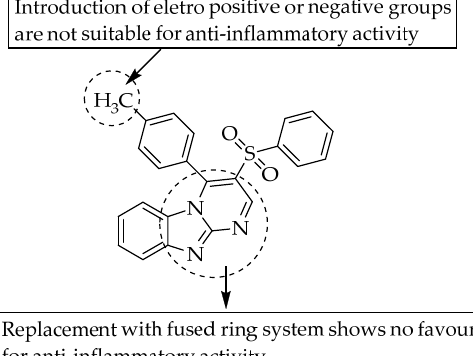
Figure 43. SARs of pyrimido[1,2-a]benzimidazoles. El-Nezhawy et al. (2013) reported the synthesis and anti-inflammatory activity of compounds with a few pyrid-2-yl moieties substituted and polyhydroxy sugar conjugated to the N -benzimidazole moiety. The compounds 2-methyl- N -((3,4-dimethoxy pyridin-2-yl)methyl)-1 H -benzimidazol-5-amine and 1-(1,2,3,5-tetrahydroxy-a- D -mannofuranose)-5-(((3,4-dimethoxypyridin-2yl)methyl) amino)-2-methyl-1 H -benz-imidazole significantly reduced the inflammation in the paw oedema model by 62 and 72%, respectively, which is comparable to the effect of diclofenac (73%). These compounds also showed significant antiulcerogenic activity. They also showed that electron-donating methoxy groups in the pyrid-2-yl moiety mainly contributed to the compounds’ potency. A benzimidazole bearing a polyhydroxy sugar at position one had a potent anti-inflammatory effect, with remarkable anti-ulcer activity (Figure 44) [67].